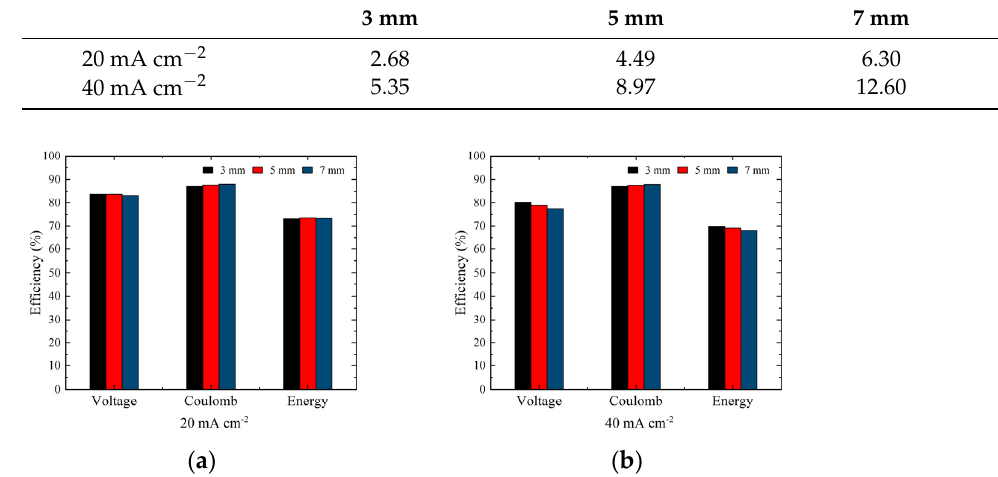
Table 5. Discharge capacities of battery with different electrode thicknesses at different current densities (Ah).